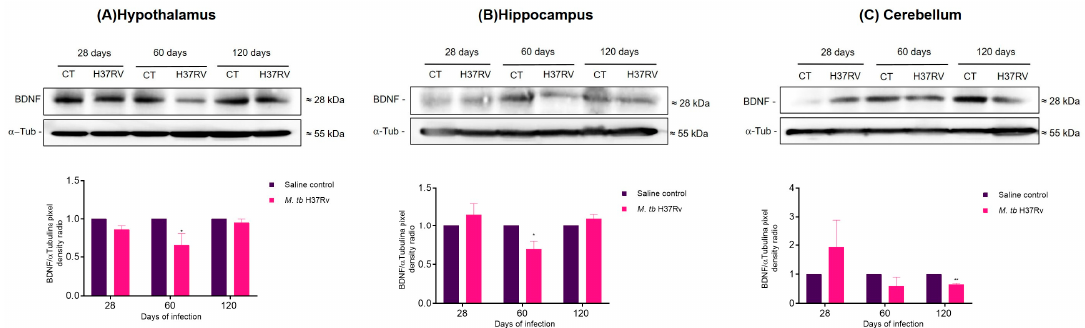
Figure 6. Production of BDNF in the hypothalamus ( A ), hippocampus ( B ) and cerebellum ( C ) of mice with pulmonary tuberculosis (TB). Upper panel shows a representative image of the Western blot at 28, 60 and 120 days post-infection. Lower panel shows the quantification of the PD ratio. BDNF levels decreased in the hippocampus and the hypothalamus at 60 days post-infection and in the cerebellum at 120 days post-infection. Data are expressed as mean ± SEM. Hypothalamus 60 days t = 3.025, * p = 0.0186, two-tail, unpaired t-test. Hippocampus 60 days t = 4.025, * p = 0.0276, two-tail, unpaired t -test. Cerebellum 120 days t = 9.391, ** p = 0.0026. ( n =